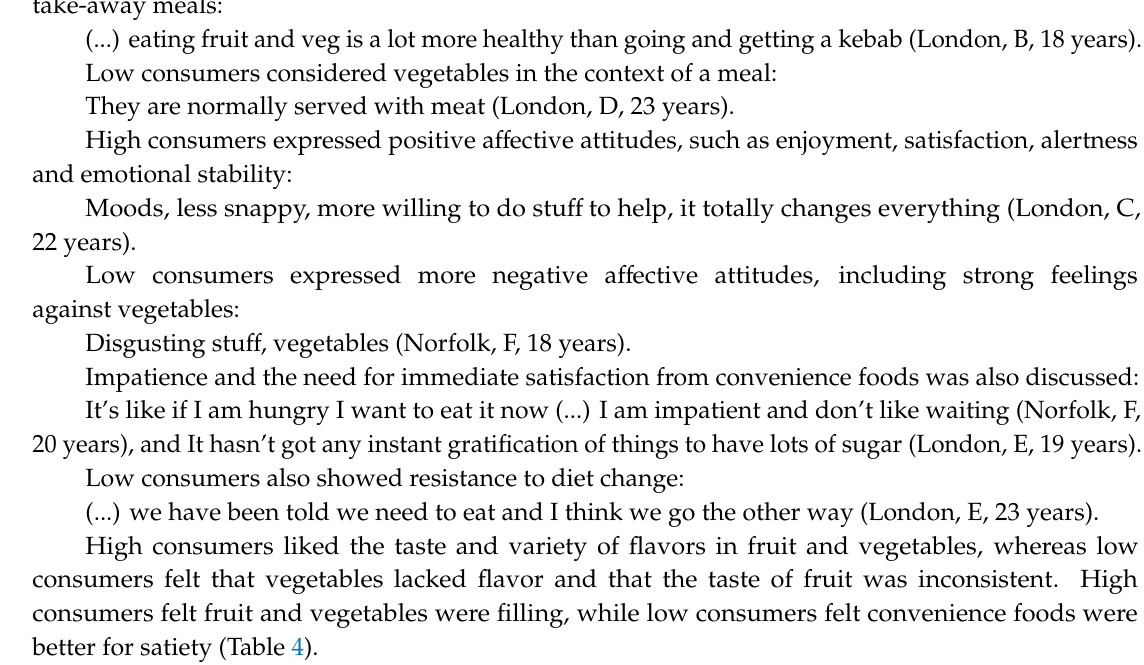
Table 4. Hedonic attitudes of young men with high and low fruit and vegetable consumption. Level of Fruit and Vegetable Hedonic Attitude